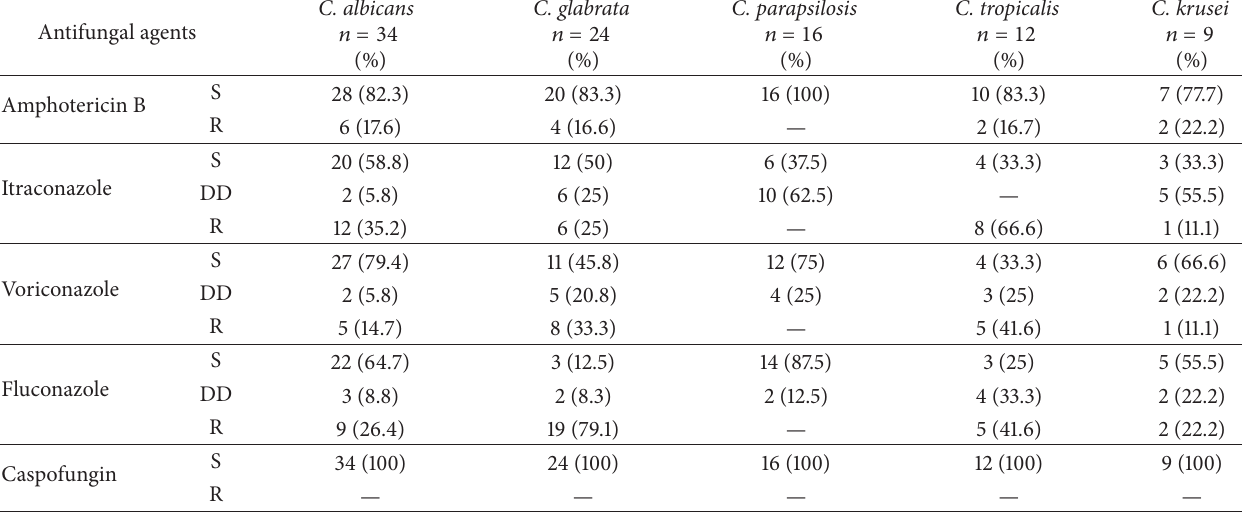
Table 2: MIC interpretation of five antifungal drugs against Candida spp. recovered from endotracheal tube. Antifungal agents Amphotericin